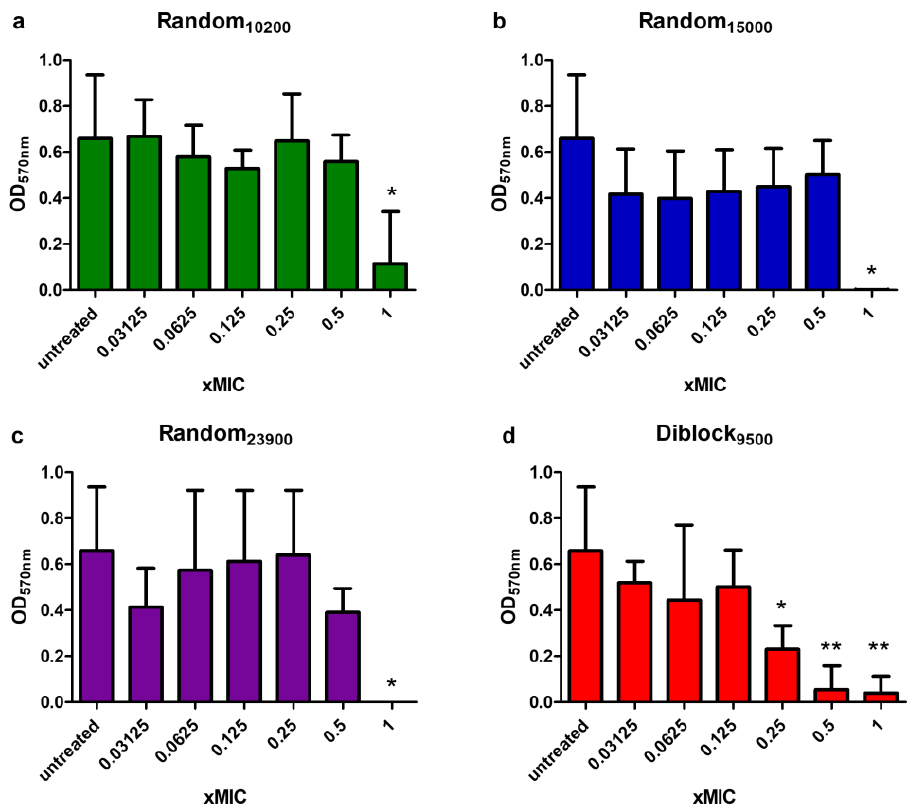
scessus S, P. aeruginosa , and S. aureus , respectively). S. aureus , respectively).